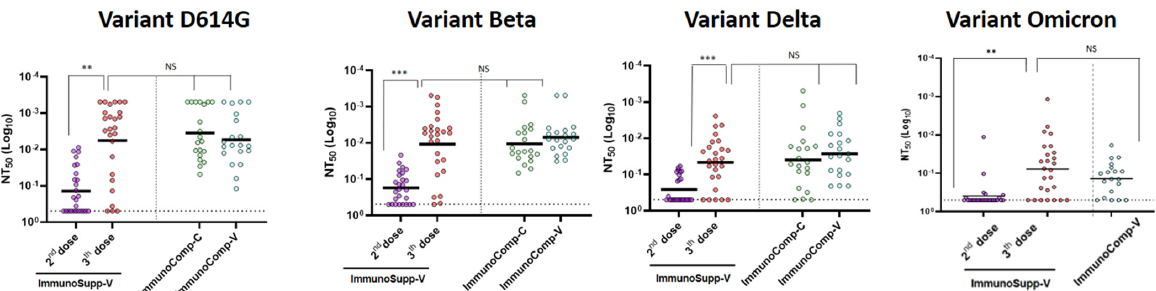
Figure 1. Immunofluorescence labeling of SARS-CoV-2 variant delta infection in Calu-3 cells and neutralization by patient serum dilutions. Representative examples of individuals from the three groups are shown, including ImmunoSupp-V (double- then triple-vaccinated allogeneic HSCT recipients), ImmunoComp-V (double-vaccinated immunocompetent healthcare workers), and ImmunoComp-C (immunocompetent non-vaccinated convalescent individuals).